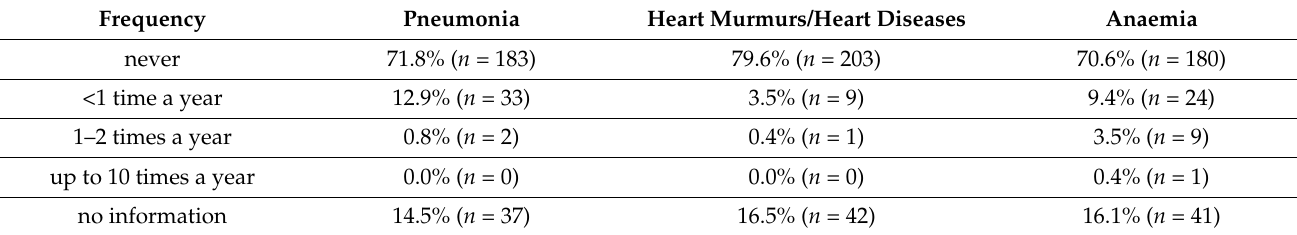
Table 9. Observation of the owners: frequency of diseases or symptoms affecting the cardiovascular system ( n = 255).